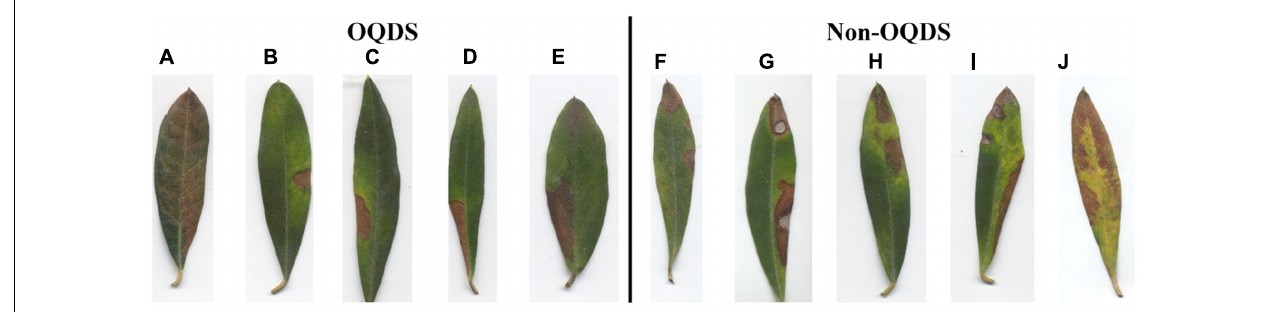
FIGURE 7 | Examples of images that were misclassified more than once across the 10 validation folds. (A–E) Images of OQDS leaves. (F–J) Images of leaves with pathogens/diseases other than